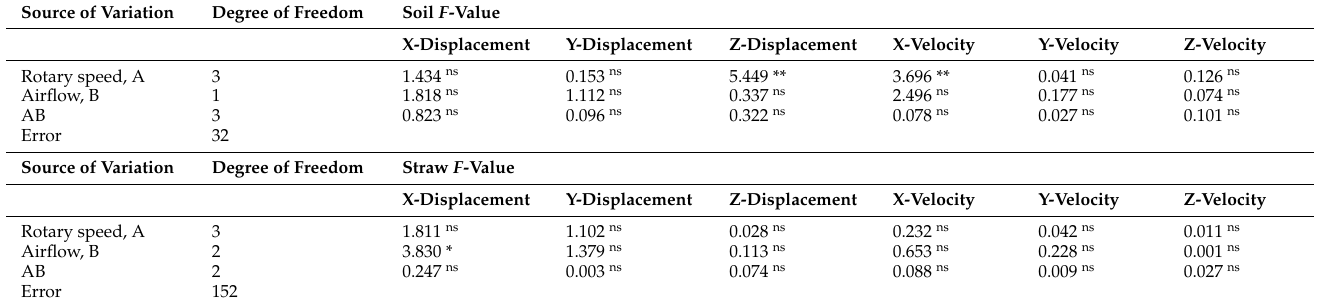
Table 2. Analysis of variance (F-test) of measured